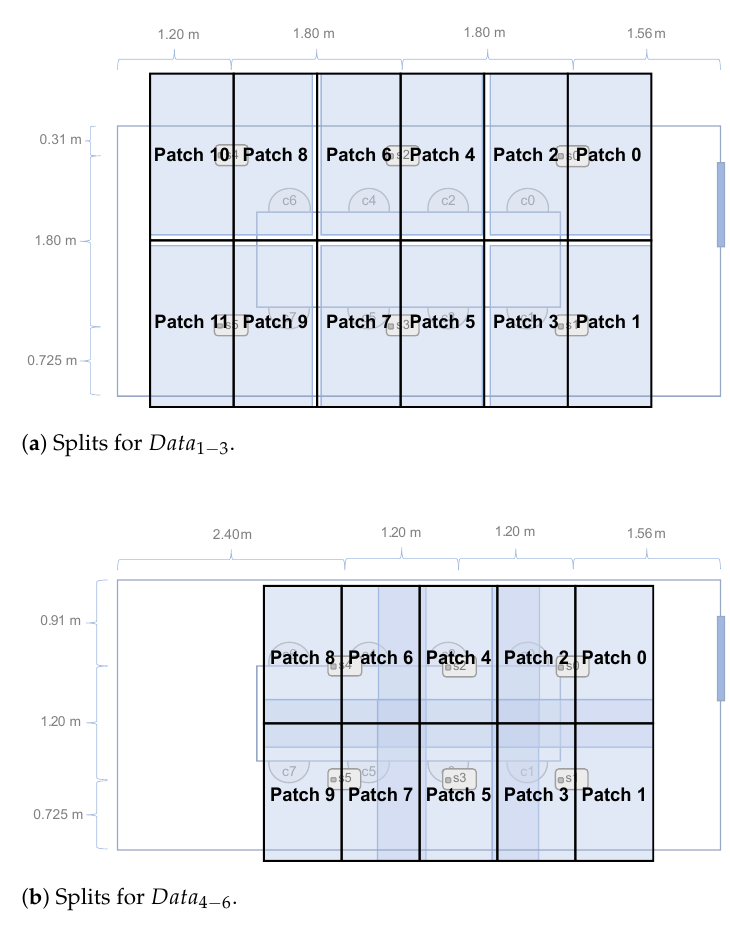
Figure 6. Illustration of how the data sets are split to obtain per-seat patches in Method